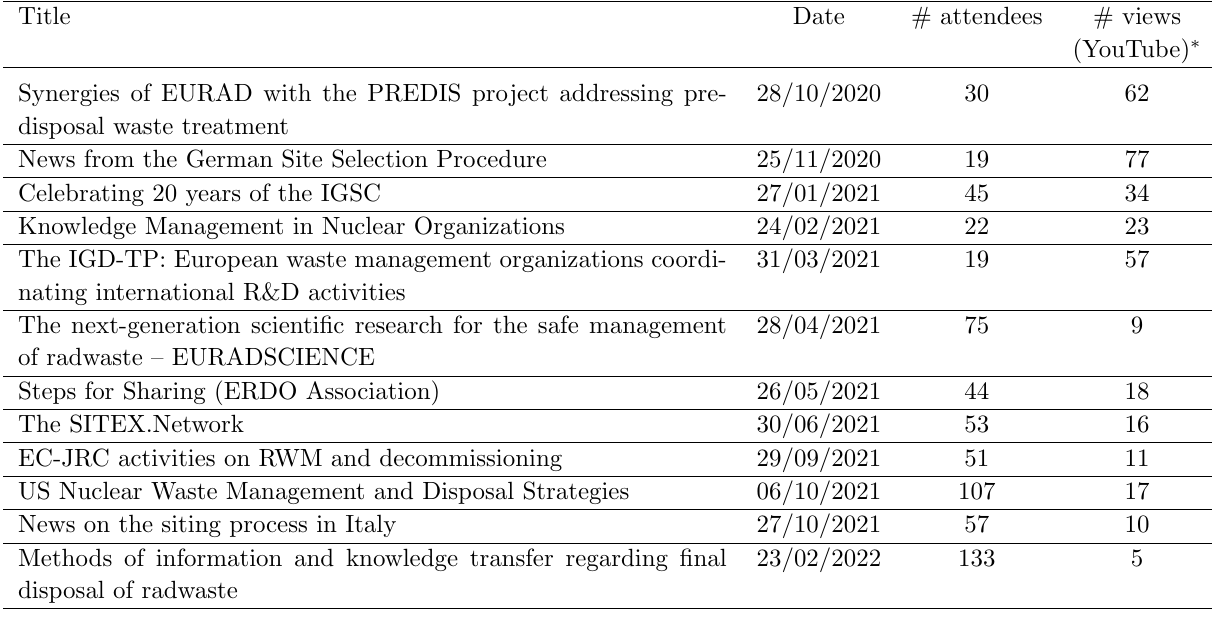
Table 1. Overview of webinars hosted by the School of Radioactive Waste